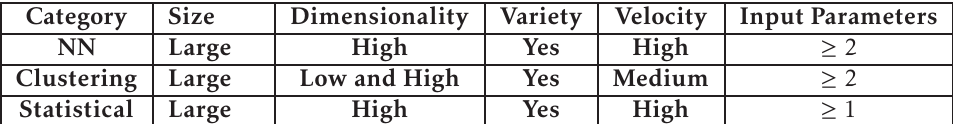
Table 1. Characteristics of anomaly detection algorithms